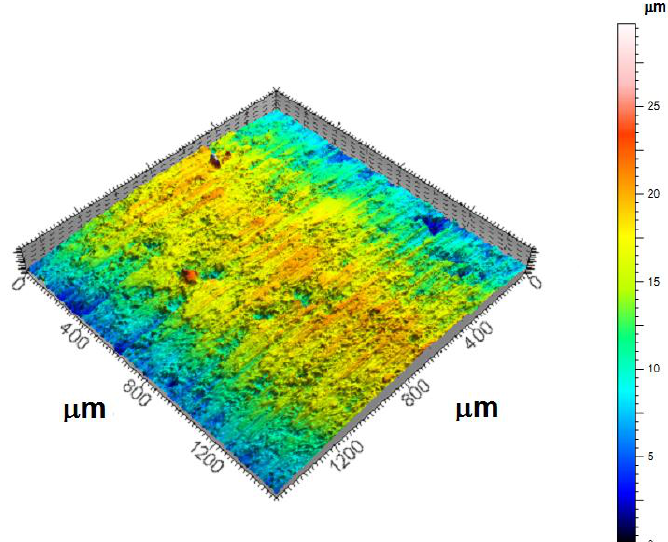
Figure 2. The example of the surface topography of the composite coatings with volume fraction ceramic dispersed phase V cdp = 15%Al 2 O 3 for inserts with WNMG 080408 S01030A CB7015, after turning.